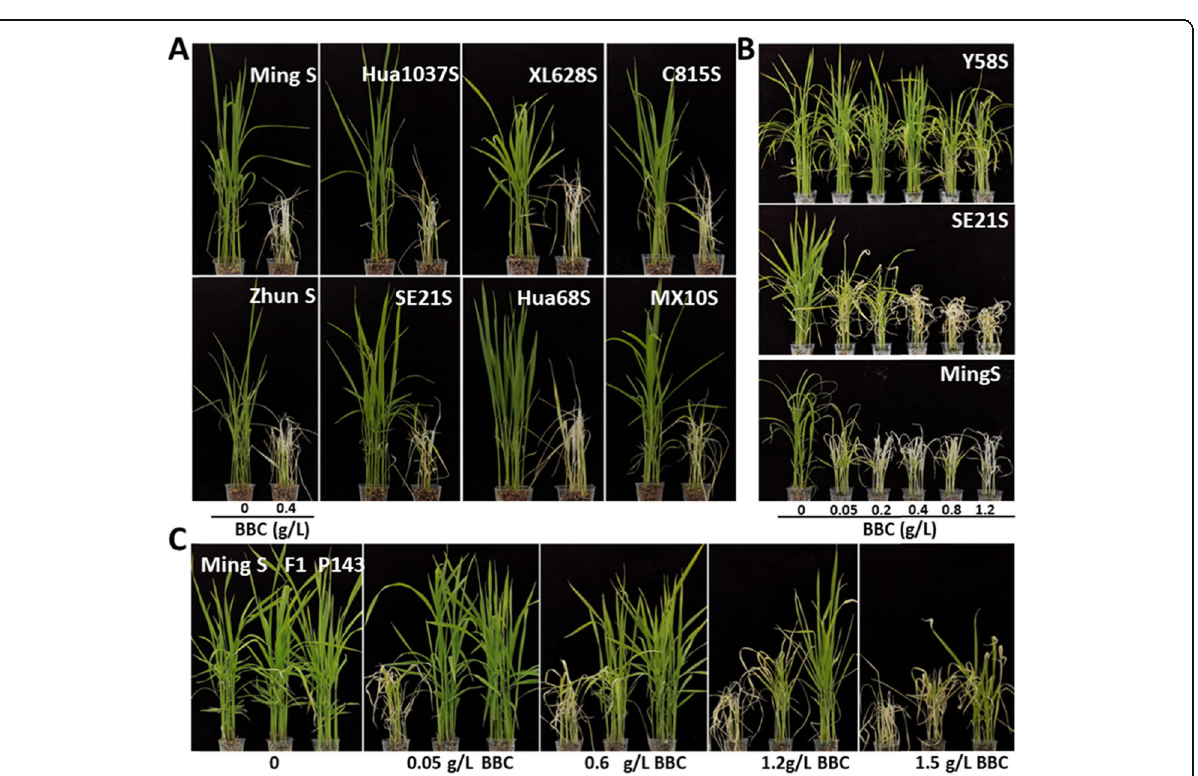
Fig. 4 Potential applications of BBC in improving the seed purity of 2-line hybrid rice. a Some 2-line P/TGMS are susceptible to BBC. b Concentration-dependent effects of BBC on three representative 2-line P/TGMS accessions, Y58S ( HIS1 ), SE21S ( his1 -T1510G), and MingS ( his1 – 28- bp deletion). c Concentration-dependent effects of BBC on the 2-line hybrid variety Mingliangyou143 (F1), female parent MingS, and male parent